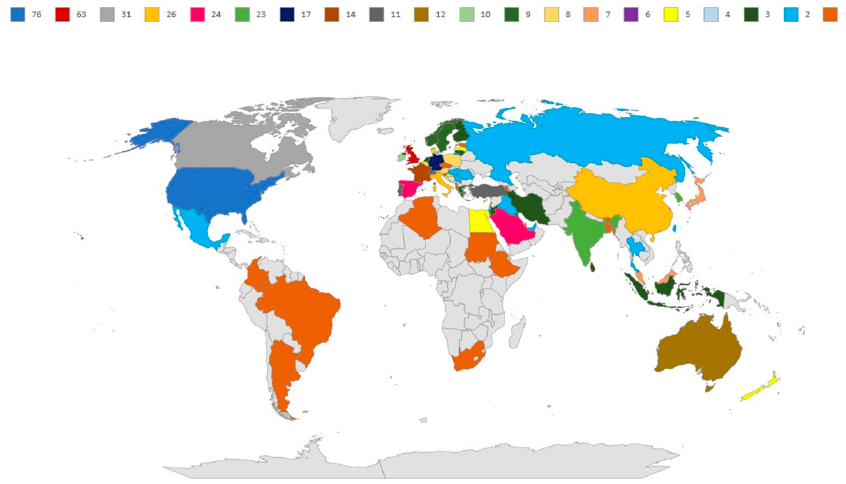
Figure 3. Geographic provenience and distribution of the publications on the topic “ thermal trans- mi tt ance assessment of building* ” (source: authors’ elaboration based on Scopus data).